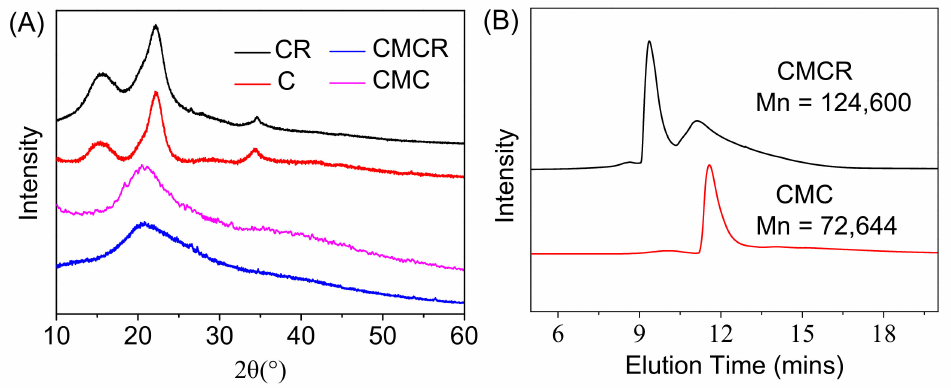
Figure 2. ( A ) XRD curves of CR, C, CMC and CMCR; and ( B ) GPC graphs of CMC and CMCR.